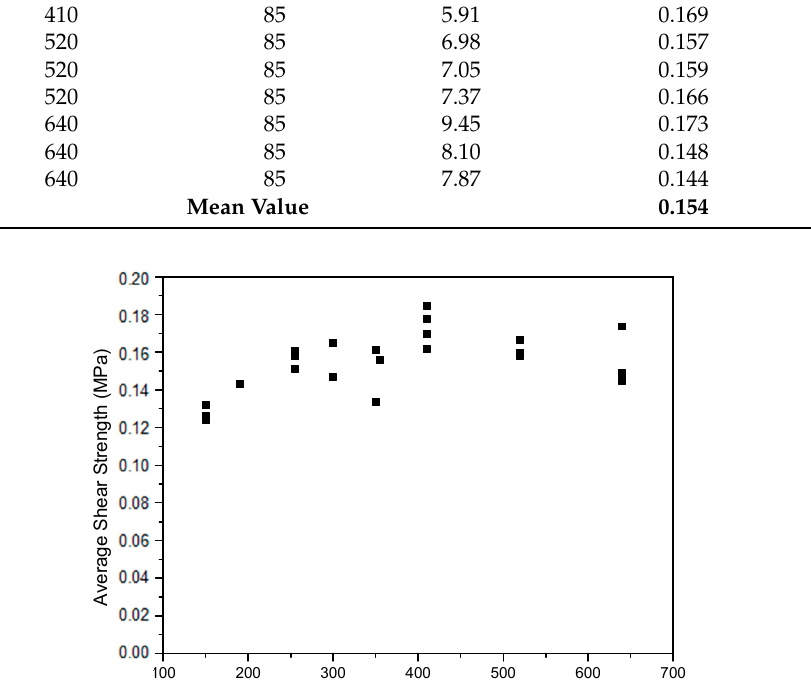
Figure 8. Average shear strength for different bonded lengths of the retrofitting system.